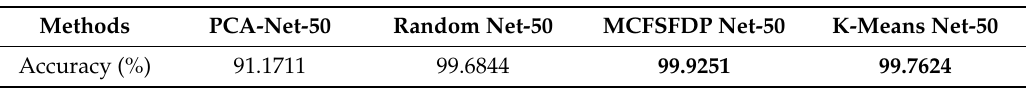
Table 6. The testing accuracy of different CNNs methods which compared with K-means Net on Dataset 2.